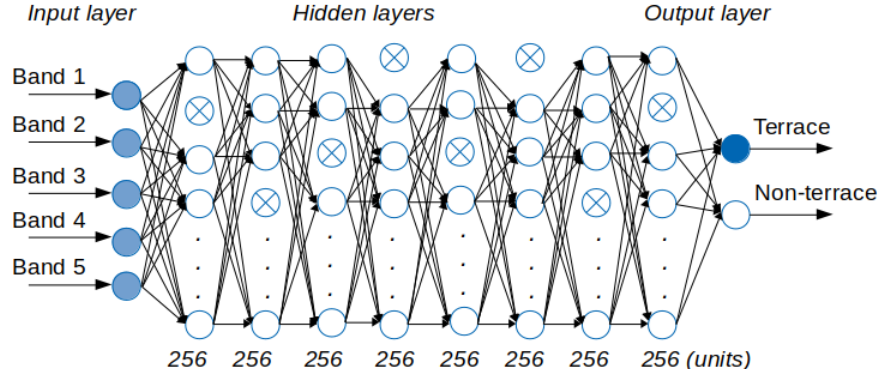
Figure 4. DNN model. In each hidden layer, 20% of units temporal randomly